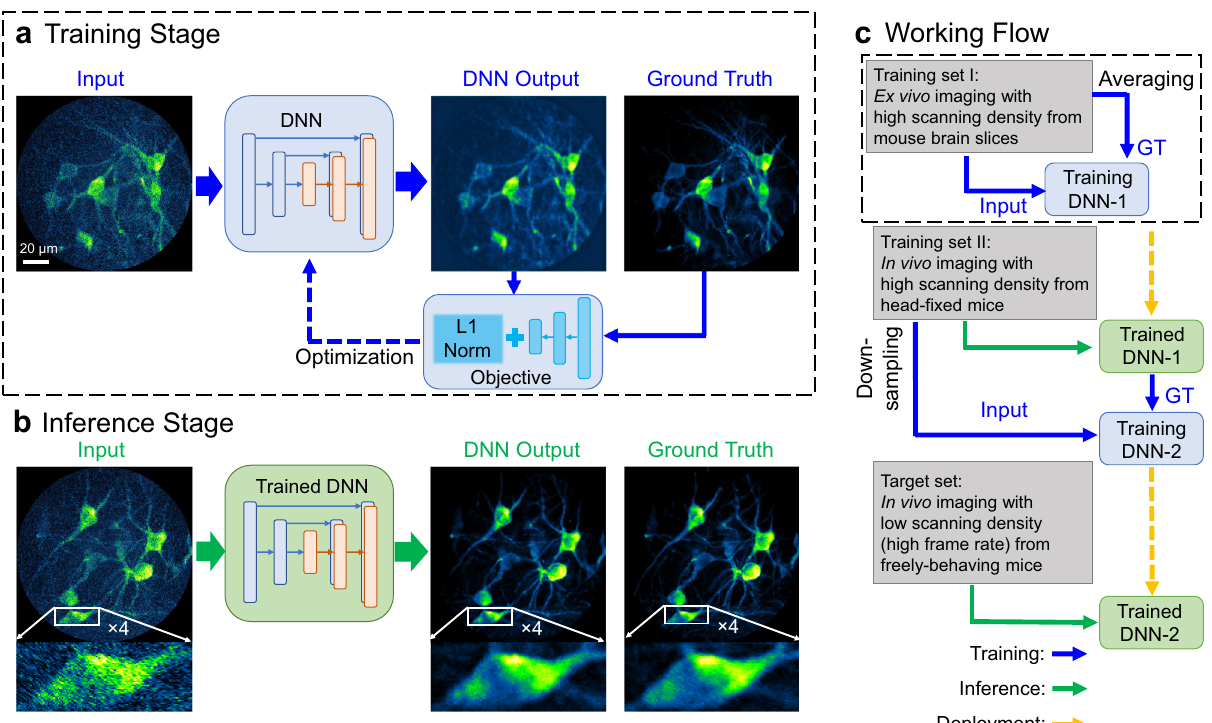
Fig. 1 Overview of the deep neural network (DNN) based method for video-rate 2P fi berscopy. a Training stage. b Inference stage. c Work fl ow of the two-stage DNNs ’ training protocol. GT ground